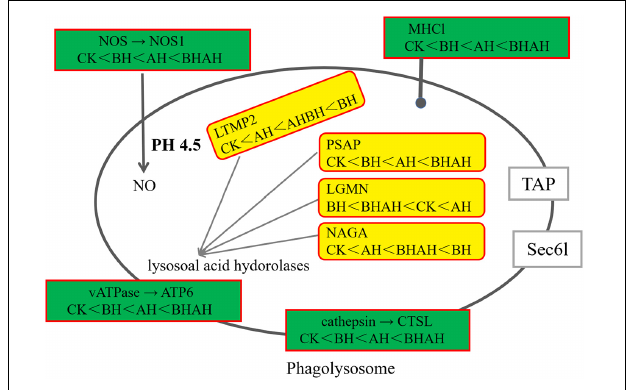
FIGURE 9 | Changes in pathways in C. japonica immersed in 100 mg/L berberine hydrochloride and injected with 10 5 CFU/L A. hydrophila .